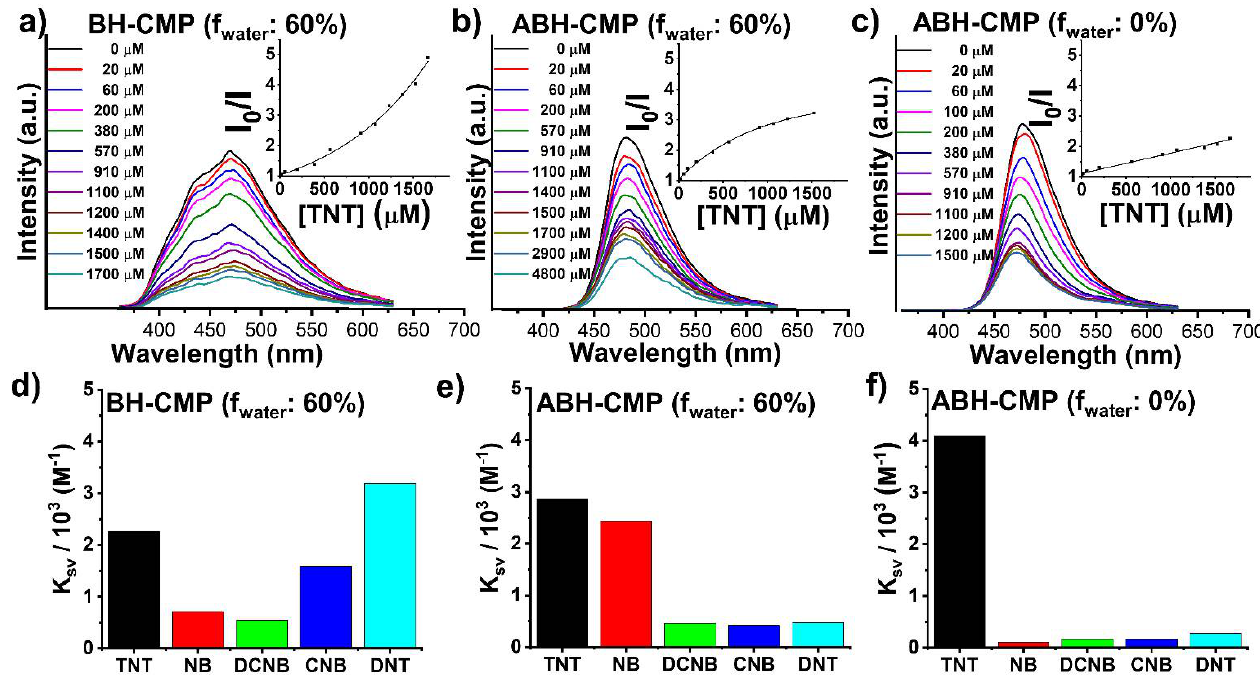
Figure 3. Photoluminescence (PL) emission spectra of ( a ) BH-CMP 60 , ( b ) ABH-CMP 60 , and ( c ) ABH-CMP 0 with different concentrations of 1,3,5-trinitrotoluene (TNT). The plots of relative PL intensity (I 0 /I) of BH-CMP 60 , ABH-CMP 60 , and ABH-CMP 0 versus TNT concentrations are provided as the inset plots (I = PL intensity, I 0 = PL intensity at a TNT concentration of 0 M). Stern-Volmer constants with TNT, NB, DCNB, CNB, and DNT for ( d ) BH-CMP 60 , ( e ) ABH-CMP 60 , and ( f ) ABH-CMP 0 .